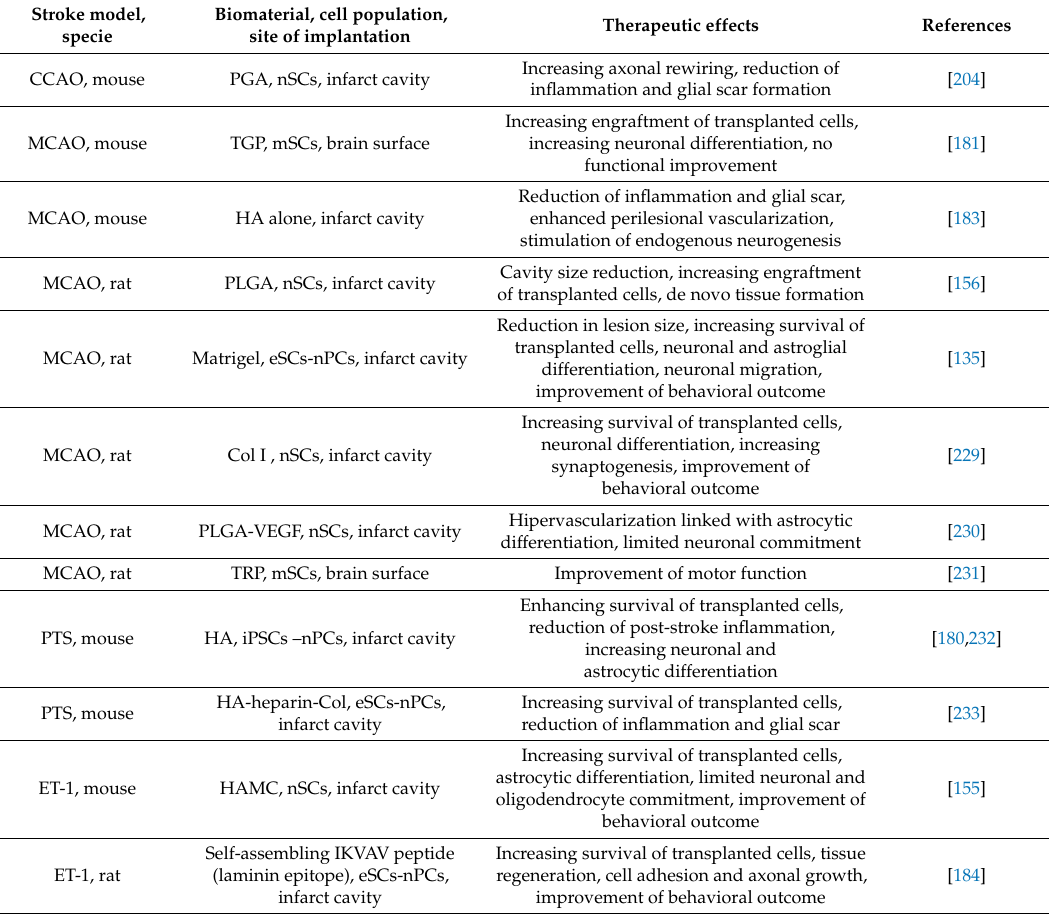
Table 2. In vivo studies using different cell populations in combination with distinct biomaterials to restore the functionality loss after brain